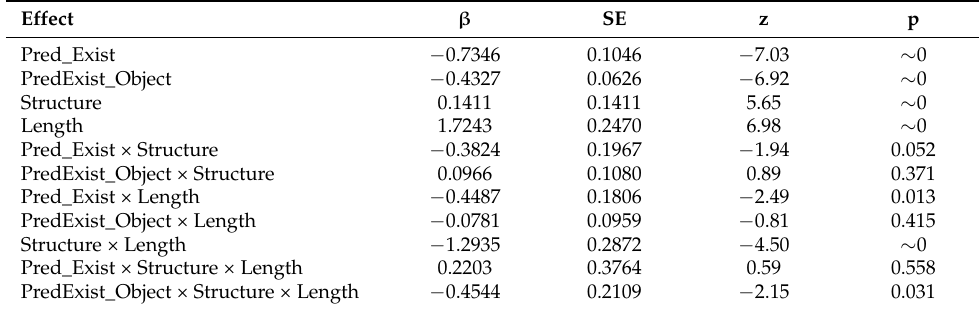
Table A14. Coefficient estimates for Experiment 1 mixed-effects model.